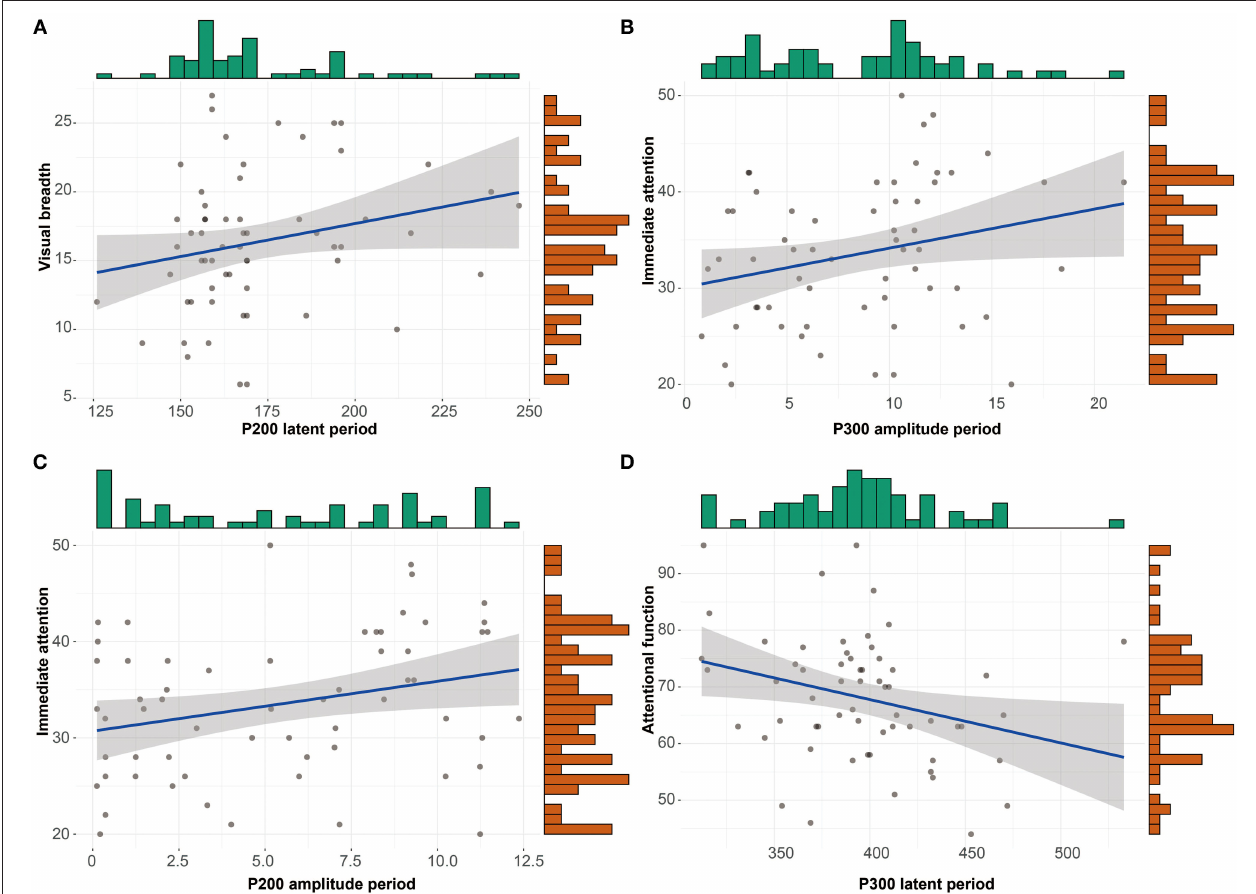
FIGURE 2 | Scattering plot depicting the correlation between items in RBANS and items in ERPs with statistical significance. (A) Correlation between visual breadth and P200 latent period. (B) Correlation between immediate attention and P300 amplitude period. (C) Correlation between immediate attention and P200 amplitude period. (D) Correlation between attentional function and P300 latent